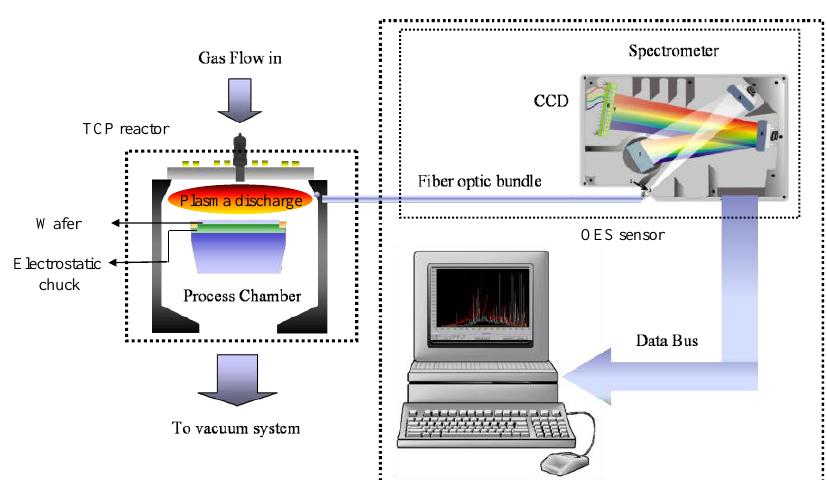
Figure 5. Overall system